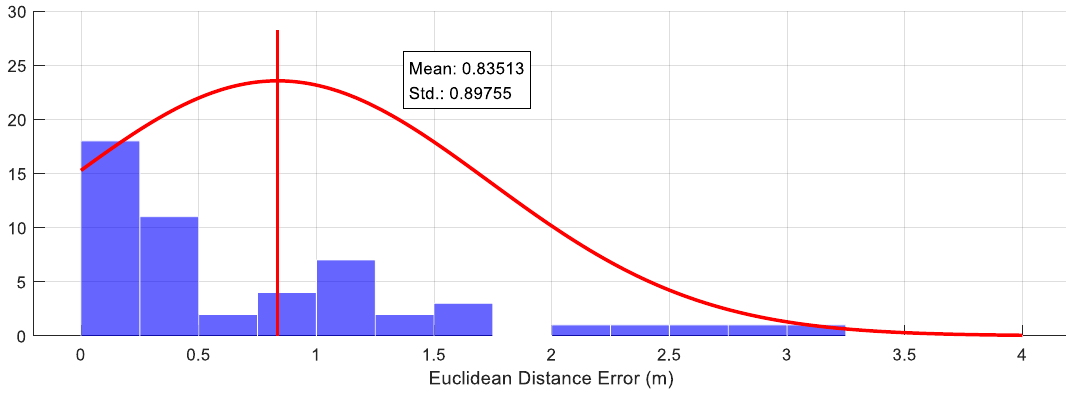
Figure 9. Mapping error for the position estimation of new map